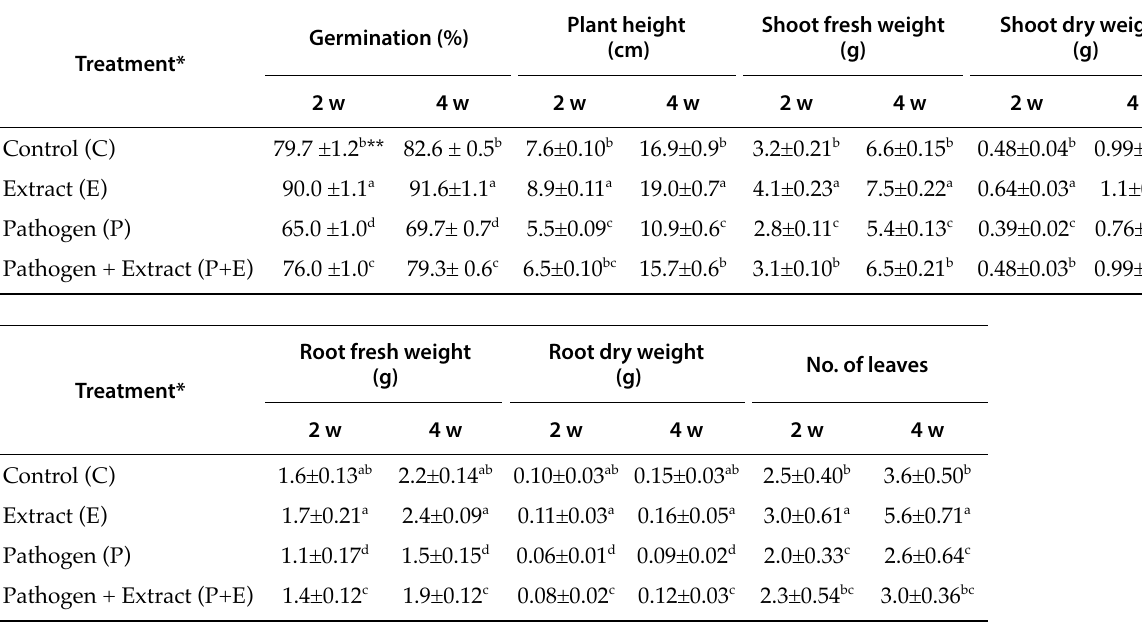
Table 4. Mean seed germination and parameters for sunflower plants, the seedlings of which received different treatments of Fusarium solani inoculation and/or turmeric extract application, at 2 and 4 weeks after treatment.